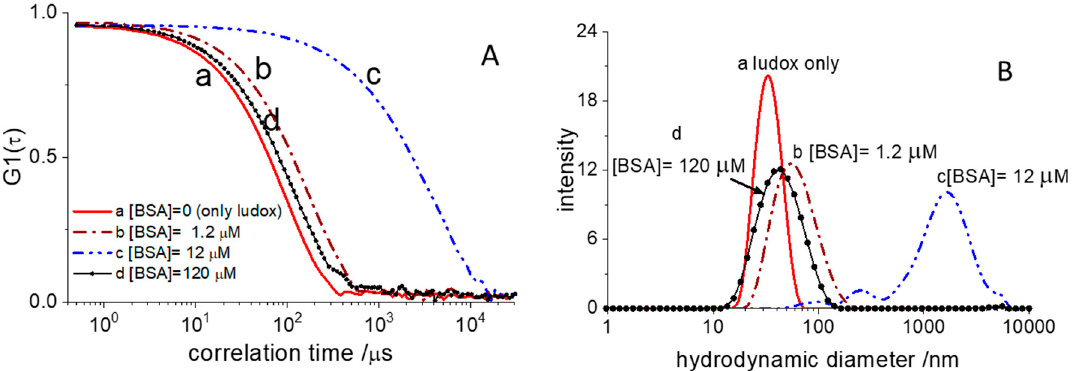
Figure 3. E ff ect of increasing BSA concentrations (0, 1.2, 12, and 120 µ M) on a sample with constant Figure 3. Effect of increasing BSA concentrations (0, 1.2, 12, and 120 μ M) on a sample with constant Ludox concentration (2.5 mg / mL) in a 10 mM phosphate bu ff er (pH 8) and constant 25 ◦ C measured by Ludox concentration (2.5 mg/mL) in a 10 mM phosphate buffer (pH 8) and constant 25 °C measured DLS. ( A ) Autocorrelation functions (ACF) and ( B ) intensity-size distributions of the by DLS. ( A ) Autocorrelation functions (ACF) and ( B ) intensity ‐ size distributions of the experiments.